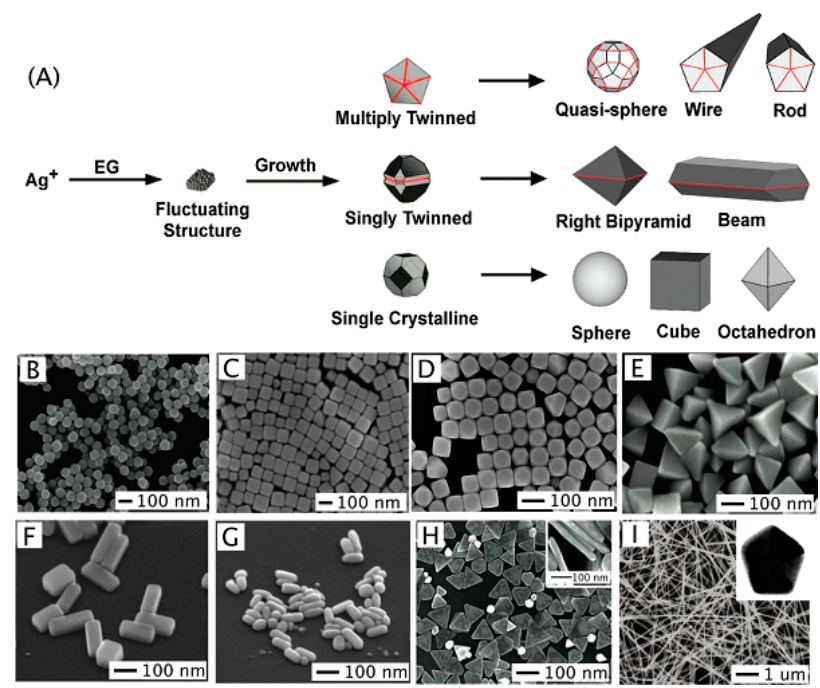
Figure 1. Synthesizing Ag nanostructures: ( A ) ethylene glycol (EG) leads to the formation of nuclei. As the nuclei grow, fluctuations cease and their structure becomes static and contains multiply twinned boundary defects, single twinned boundary defects, or are single crystalline with no boundary defects. The seeds are then grown into different nanostructures like ( B ) spheres, ( C ) cubes, ( D ) truncated cubes, ( E ) right bipyramids, ( F ) bars, ( G ) spheroids, ( H ) triangular plates, and ( I ) wires. Reprinted with permission from Chemical Reviews, 2011, 111, 6, 3669–3712. Copyright (2011) American Chemical Society.